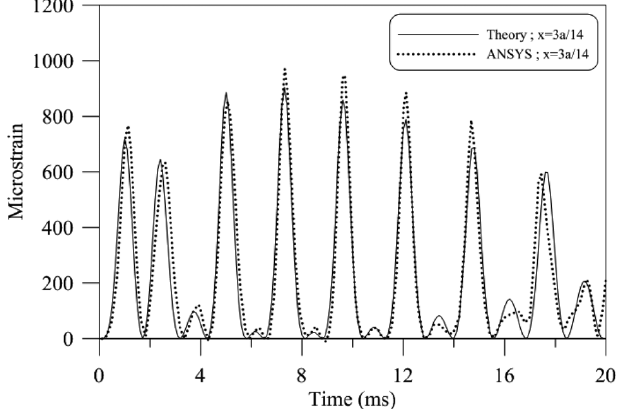
Fig. 8. The strain-time history ( ε xm − t ) at the middle surface of point (3a/14,